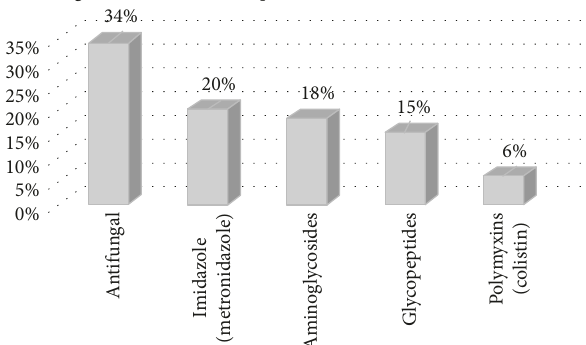
Figure 3: Distribution of antibiotic consumption in class “others” expressed in percentage of antibiotic consumption. Five of the most often used antibiotics in this